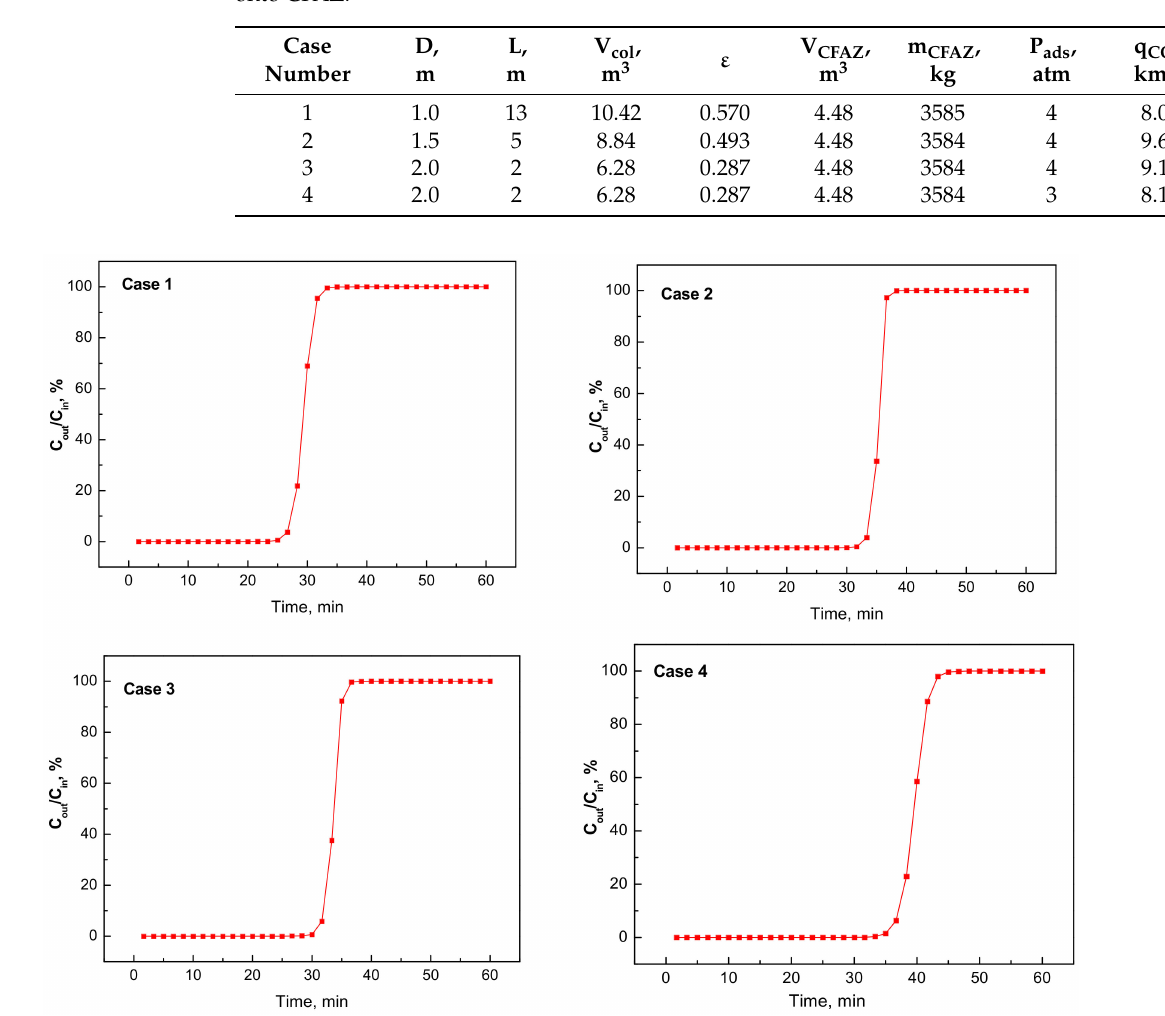
Figure 12. Break through adsorption curves of carbon caption in pilot adsorption columns with CFAZ as an